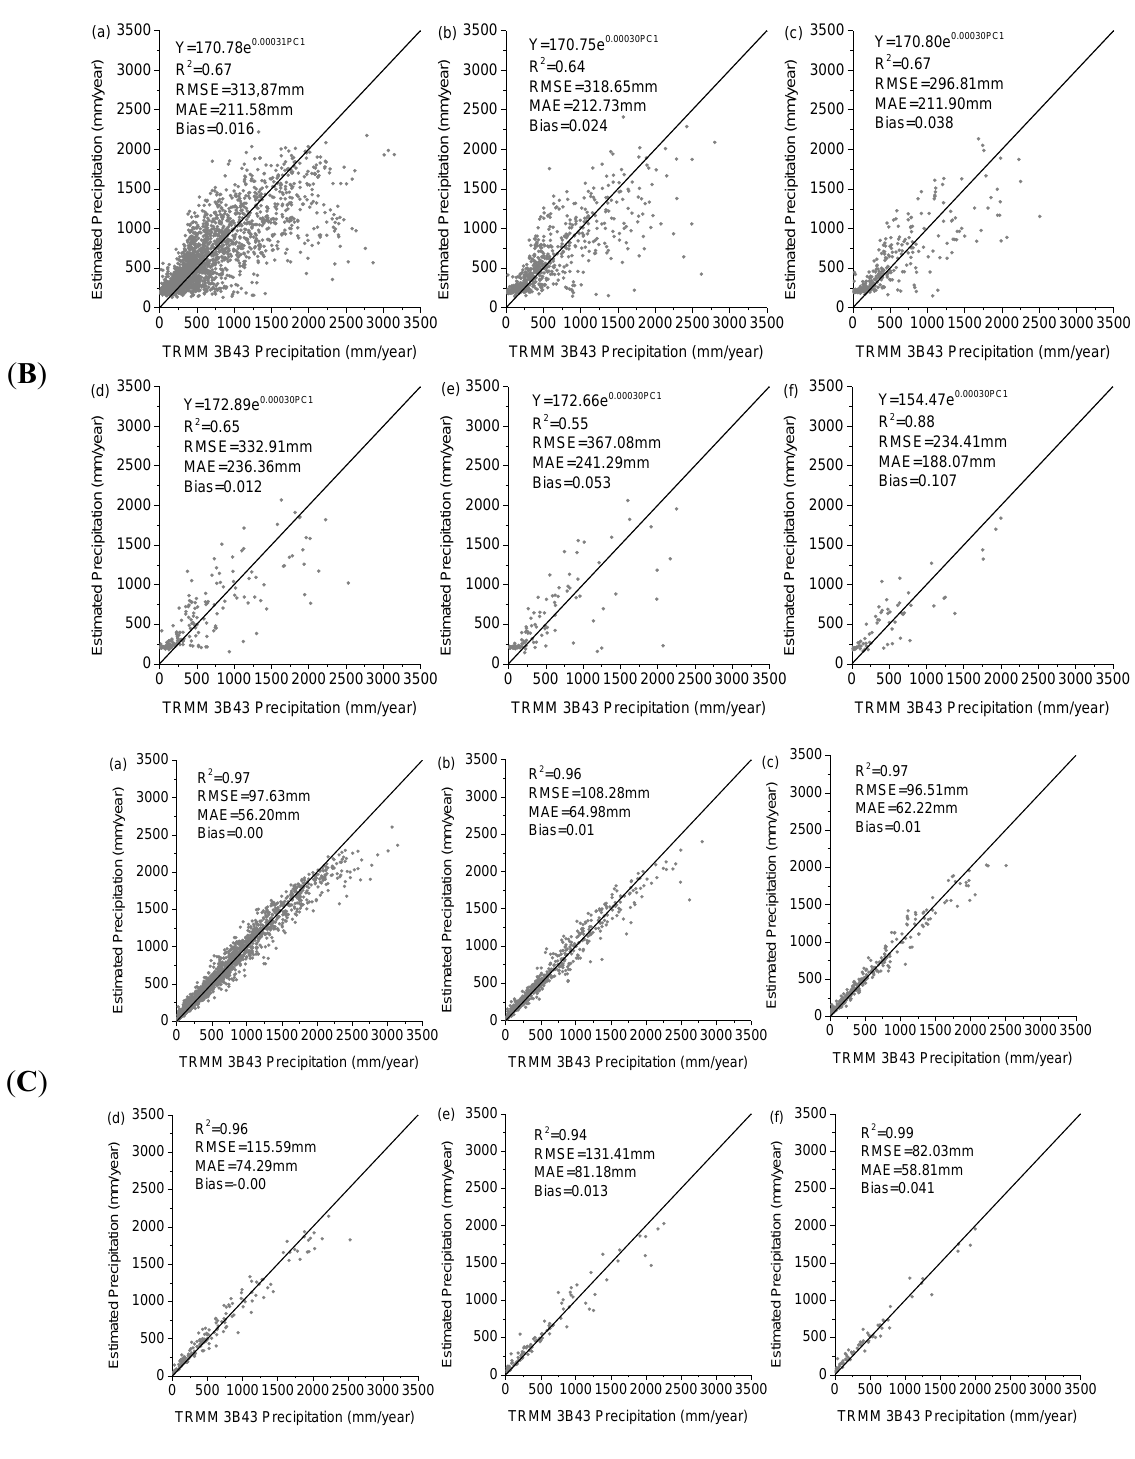
Figure A2. Scatter plots of the agreements between the annual precipitations of China mainland in 2001 derived from the TRMM 3B43 and ( A ) the multiple linear regression models, ( B ) exponential models, and ( C ) random forest models at spatial resolutions of ( a ) 0.25°, ( b ) 0.50°, ( c ) 0.75°, ( d ) 1.0°, ( e ) 1.25°, and ( f ) 1.50°, respectively. Principal component analysis has been used in the multiple linear and exponential regression